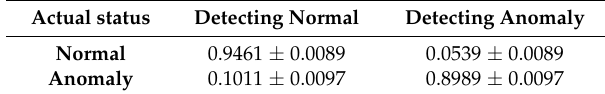
Table 7. Performance of the decoding-based model.